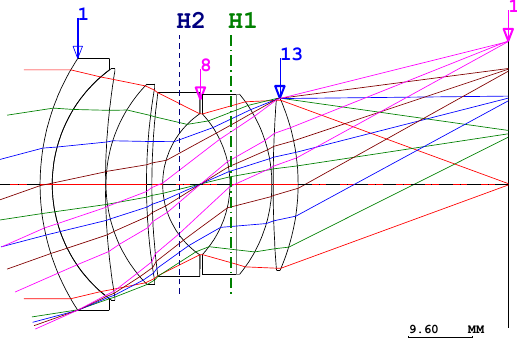
Figure 1. Optical layout of the conventional double-Gauss lens.